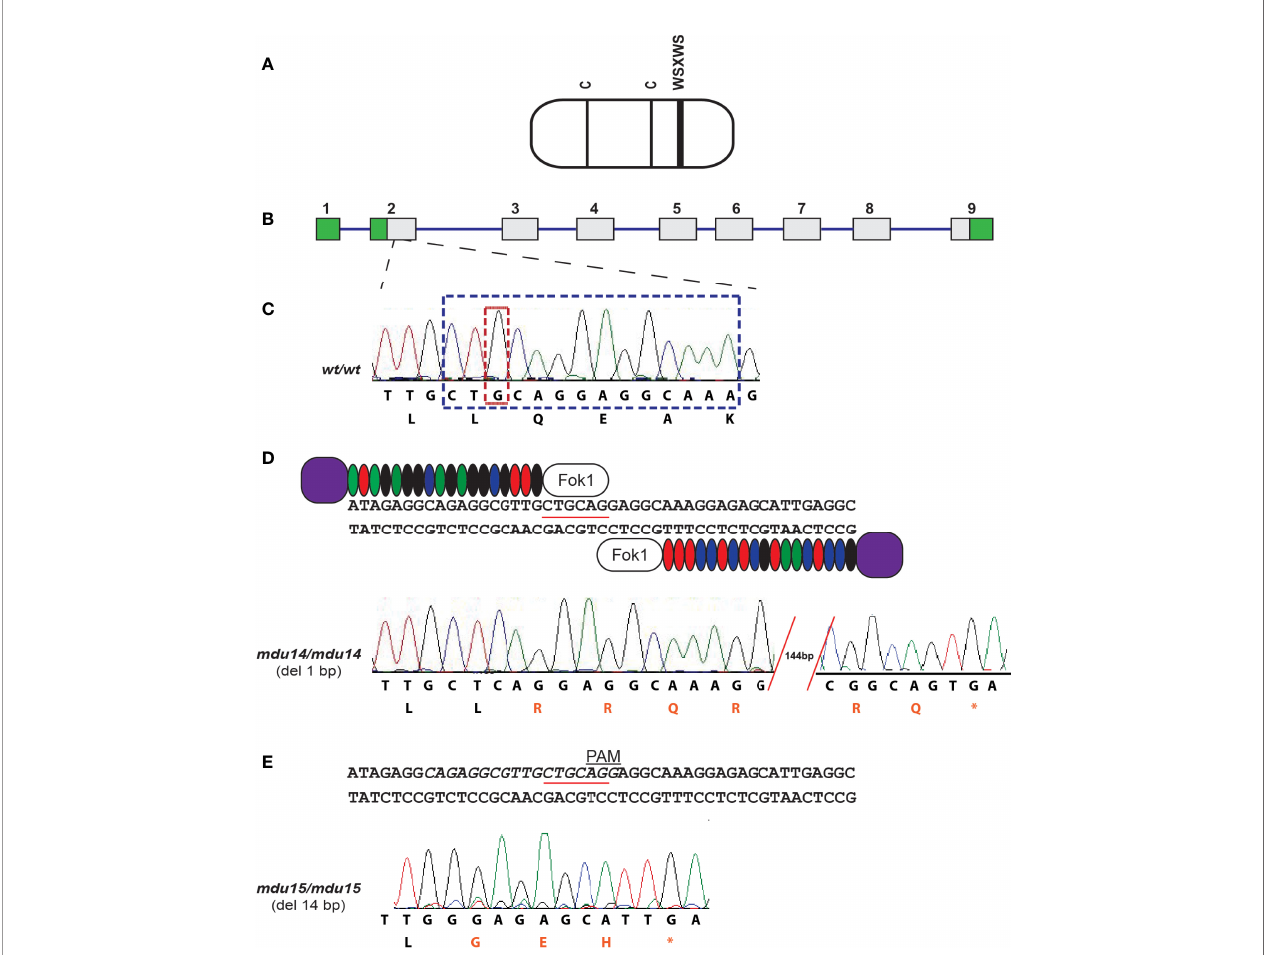
FIGURE 2 | Generation of zebra fi sh crlf3 mutants using genome editing. (A) Schematic representation of the CRLF3 protein, consisting mostly of a cytokine receptor homology domain (rounded rectangle) containing two conserved cysteines ( C , thin lines) and a WSXWS motif (thick line). (B) The intron/exon structure of the zebra fi sh crlf3 gene, with exons represented as numbered boxes, showing untranslated (green) and translated (gray) regions, and introns represented with intervening lines. (C) Sequence trace of homozygous wild-type crlf3 wt/wt ( wt/wt ) and its corresponding nucleotide sequence and encoded amino acids shown below. Nucleotides deleted in mdu14 and mdu15 alleles are boxed in tan and blue, respectively. (D) Targeting of exon 2 with TALENs, with the Pst I site used in RFLP analysis underlined, to generate the mdu14 allele, with the sequence of a homozygous crlf3 mdu14/mdu14 ( mdu14/mdu14 ) mutant shown. This represents a 1 bp deletion that causes a frameshift resulting in translation from an alternative reading frame (red) followed by a stop codon (*) that prematurely truncates the protein. (E) Targeting of exon 2 with CRISPR, with target site italicized and PAM site indicated, to generate the mdu15 allele, with the sequence of a homozygous crlf3 mdu15/mdu15 ( mdu15/mdu15 ) mutant shown. This 14 bp deletion also causes a frameshift and premature